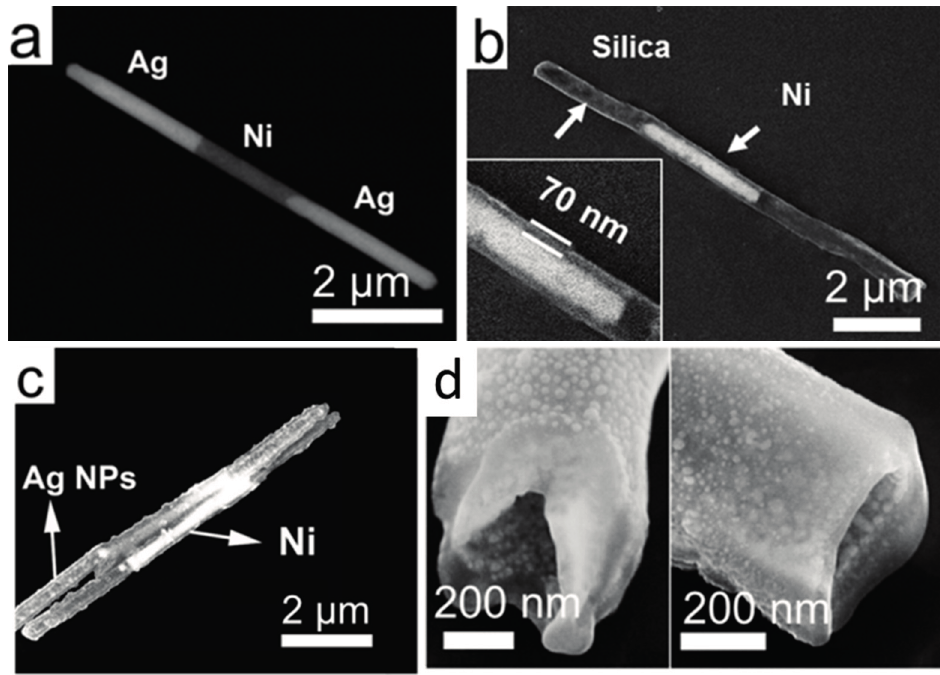
Figure 11. Scanning Electron Microscopy images of ( a ) multisegment Ag/Ni/Ag nanowires; ( b ) silica nanotubes embedded with Ni nanomagnets; ( c ) silica nanotubes with Ni segments and surface-coated Ag NPs; ( d ) cross-sectional images of nanotubes obtained by FIB milling show the nanotubes are hollow with Ag NPs on both the inner and outer surfaces. With permission from [73].